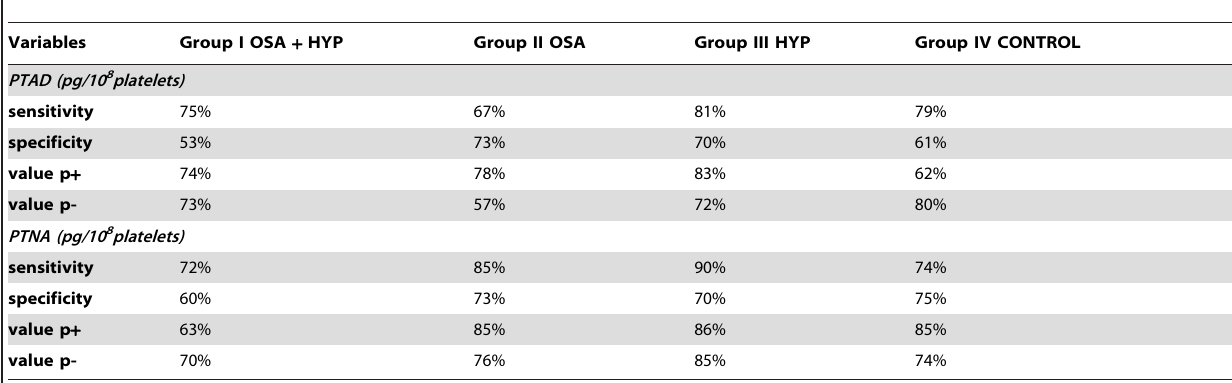
Table 3. Calculations of sensitivity, specificity and positive and negative predictive values of PTAD and